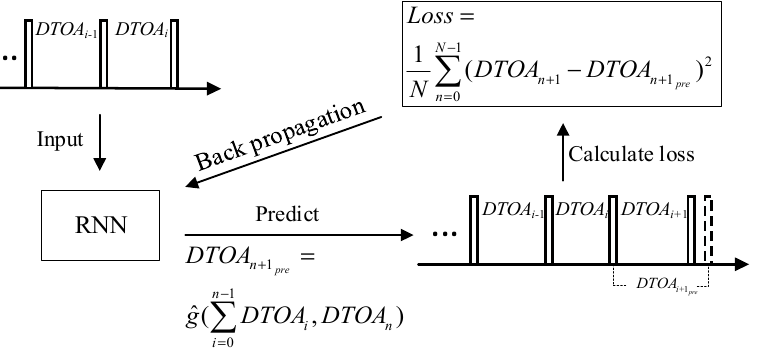
Figure 2. Flow chart of PRI feature learning using RNN.